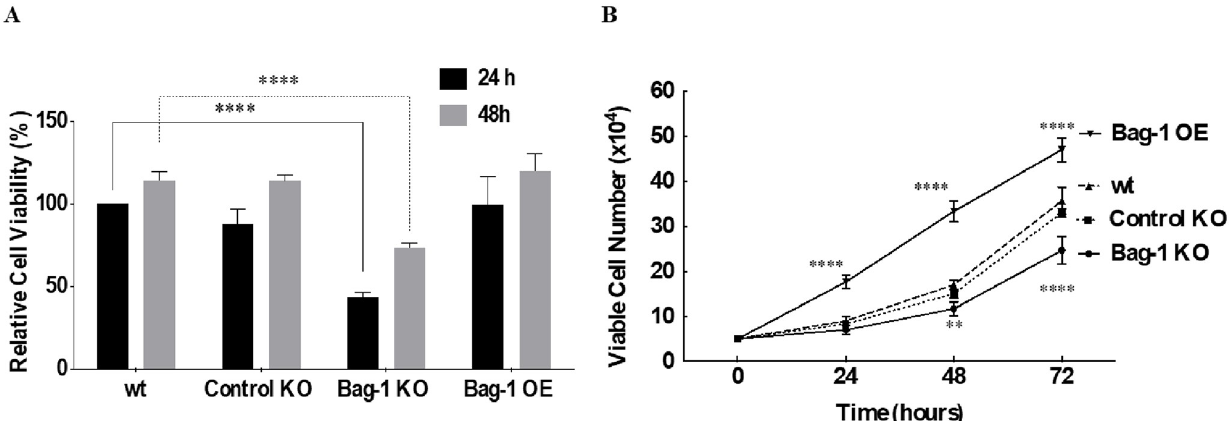
Fig 2. The knockout of Bag-1 suppressed the cell survival and proliferation of MCF-7 cells. A) Cell viability of wt, Control KO, Bag-1 KO, and Bag-1 OE cells was performed by MTT assay. The bar histograms represented the mean ± SD of three independent experiments with at least four replicates ( ���� p < 00001 by Two-way ANOVA, Sidak’s multiple comparison test). B) Cell proliferation of wt, Control KO, Bag-1 KO and Bag-1 OE was determined by Trypan Blue Dye Exclusion assay in a time-dependent manner (0–72 h). The mean ± SD of three repetitive experiments were analyzed by Two-way ANOVA, Tukey’s multiple comparison test. ( �� , p = 0.0020, ���� p <